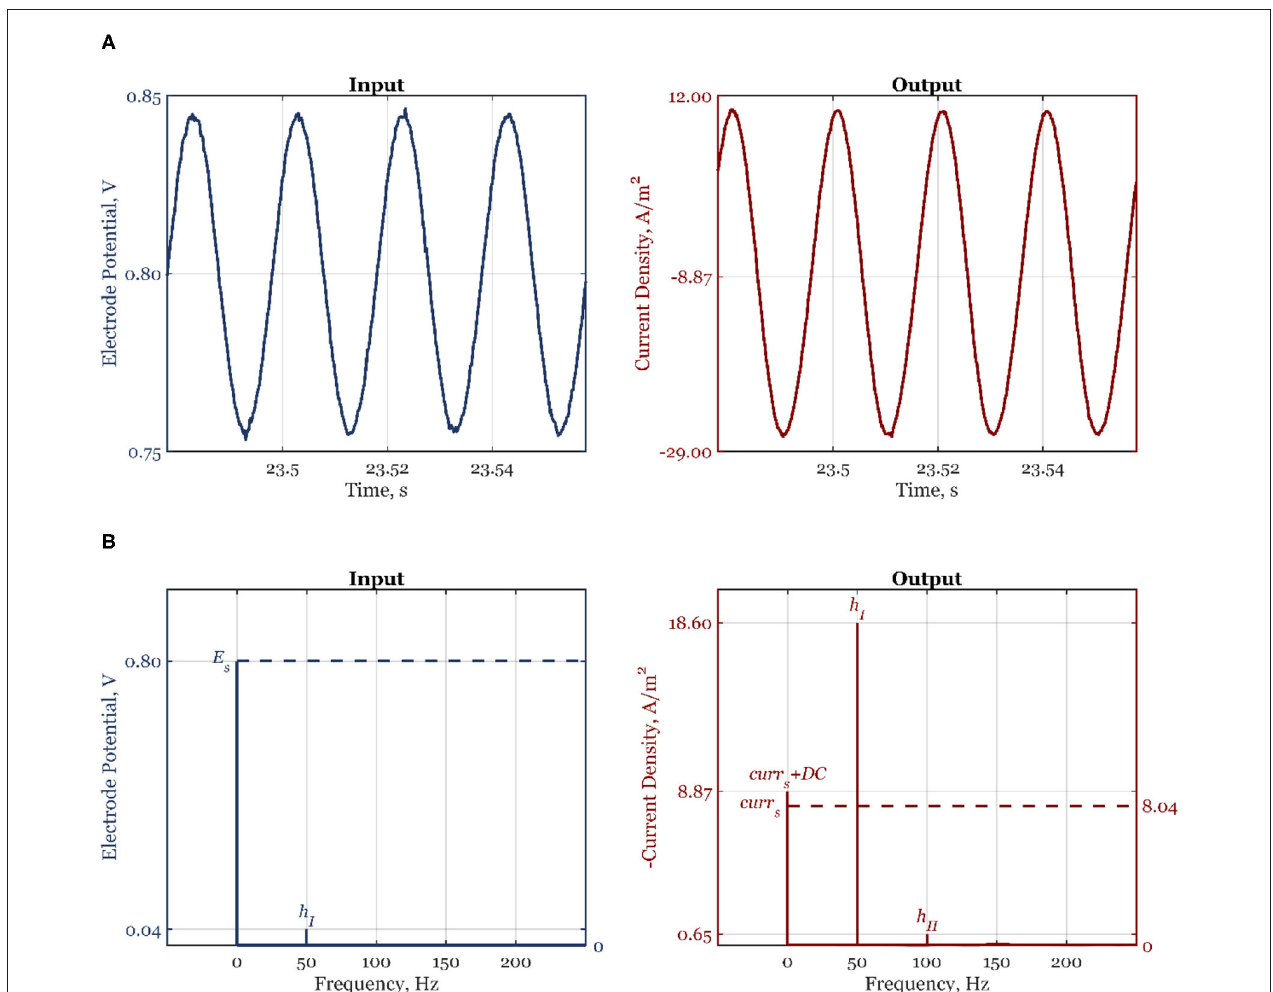
FIGURE 1 | Experimental time-domain (A) and frequency-domain (B) signals of the electrode potential, and current density, for the forcing frequency f = 50Hz, amplitude A 1 = 0.053, and the steady-state electrode potential value E s =